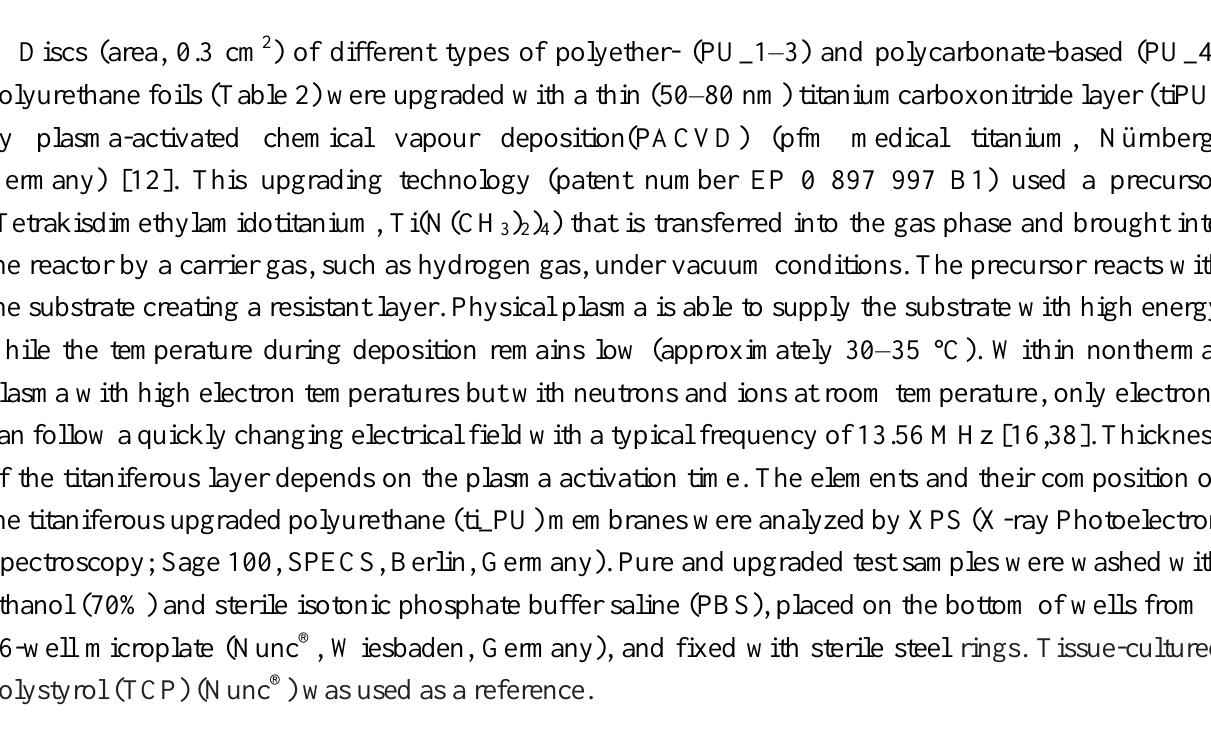
Table 2. Overview of used